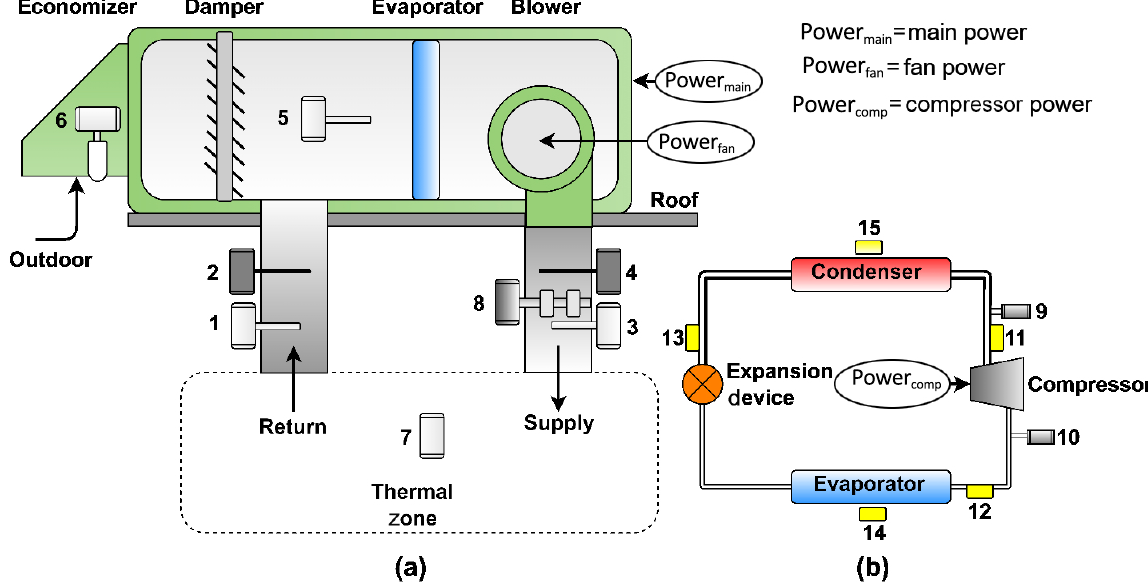
Fig. 1 (a) A schematic of an RTU with labels indicating air-side sensor locations; (b) A schematic of the vapor compression cycle with labels indicating refrigerant side pressure and temperature instrument